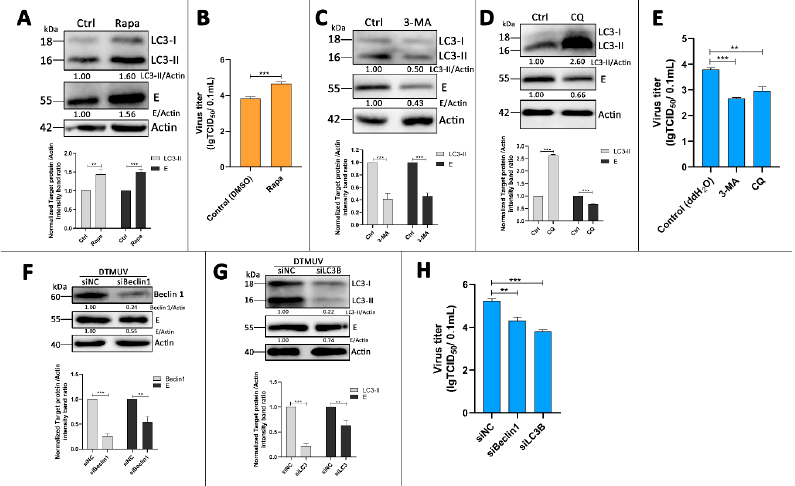
Figure 4. Effect of autophagy on DTMUV replication. ( A , C , D ) DEF cells were treated with Rapa (500 nM, DMSO as control) ( A ), 3-methyladenine (3-MA) (5 mM, ddH 2 O as control) ( C ), chloroquine (CQ) (20 μ M, ddH 2 O as control) ( D ) for 4 h prior to infection and then infected with DTMUV at an MOI of 1 for 24 h. Samples were harvested for Western blot analysis and immunoblotted for LC3, DTMUV-E, and β -actin. The ratios of targeting proteins to β -actin were normalized to control. ( B , E ) DEF cells were with the same pharmaceutical treatments as in ( A , C , D ), and then infected with DTMUV at an MOI of 0.01 for 24 h. Progeny virus yields in DEF cells were determined by TCID50 assay. ( F , G ) DEF cells were transfected with siBeclin 1 ( F ), siLC3B ( G ), or siNC for 24 h prior to infection and then infected with DTMUV at an MOI of 1 for 36 h. Samples were harvested for Western blot analysis and immunoblotted for LC3, DTMUV-E, and β -actin. The ratios of targeting proteins to β -actin were normalized to control. ( H ) DEF cells were with the same transfections as in ( F , G ), and then infected with DTMUV at an MOI of 0.01 for 36 h. Progeny virus yields in DEF cells were determined by TCID50 assay. Error bars: Mean ± SD of three independent experiments. Two-tailed Student’s t -test; ** p < 0.01, *** p <